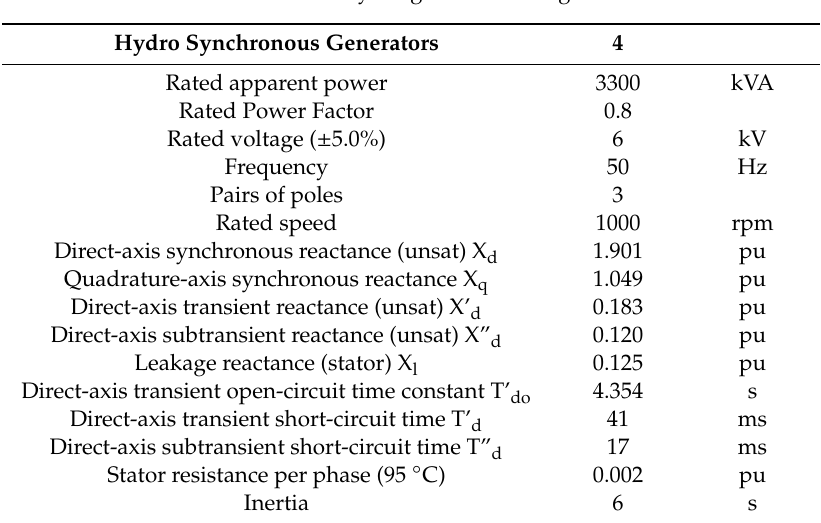
Table A3. Hydro generator